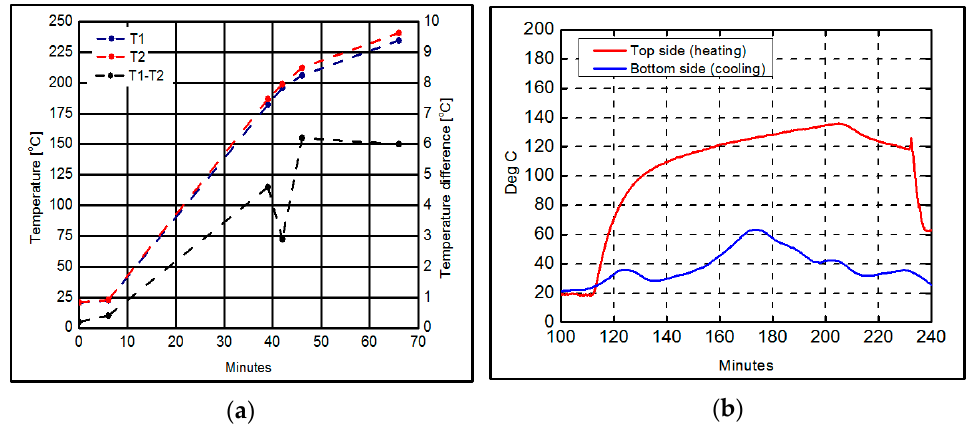
Figure 16. Heating curves for piston model with water cooling, continuous regime: ( a ) piston model with no TBC; ( b ) piston model with TBC. (T1 is the temperature measured at the top of the coating and T2 is the temperature measured at the bottom surface of the piston model; the temperature difference is shown on the right-hand side vertical axis).